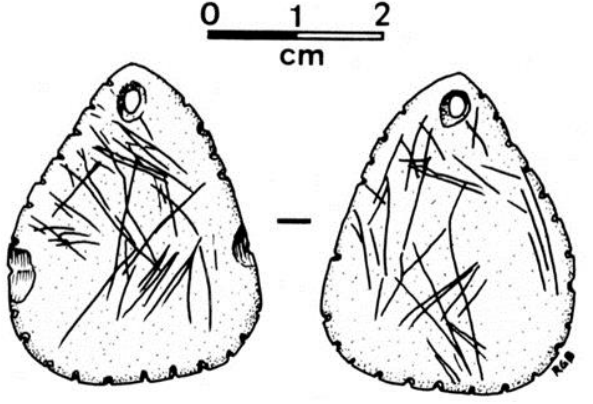
Figure 5. The notched pendant from Oshurkovo, near Ulan-Ude, southern-central Siberia, engraved on both